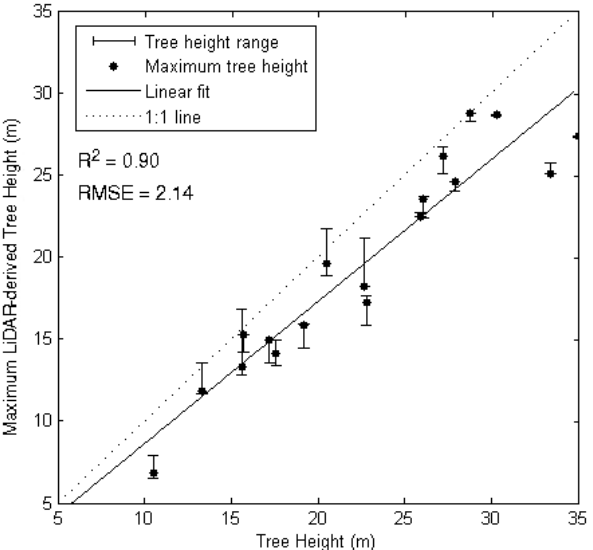
Figure 6. LiDAR-derived vs. field-measured maximum tree height per plot; the GPS-introduced uncertainty was accounted for by the variance in maximum canopy model-based tree height when shifting the plot center by 5 m in any